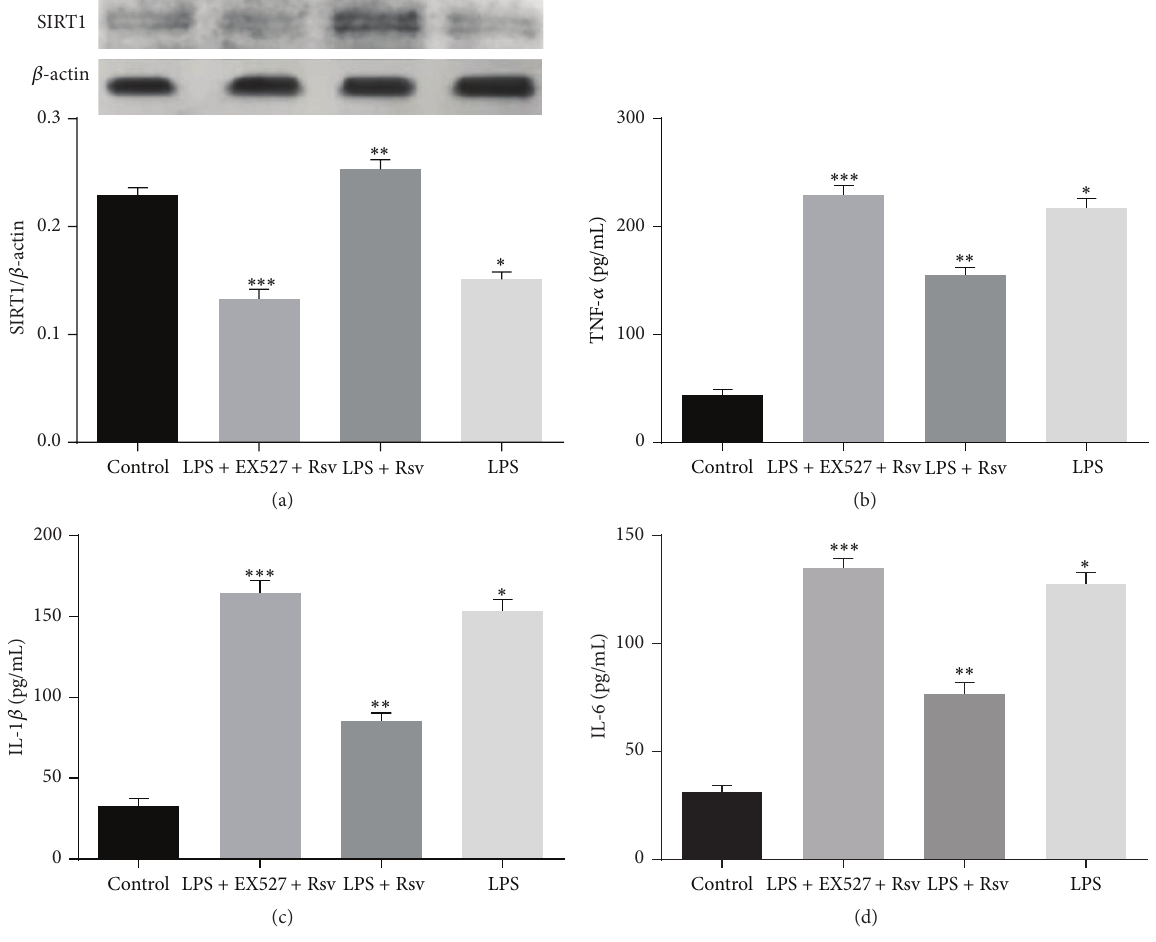
Figure 8: Neutralizing effects of EX527 on the protecting effects of Rsv on LPS stimulated NR8383 cells. (a) Expression of SIRT1 was evaluated by western blot and normalized to the expression level of 𝛽 -actin. LPS stimulation inhibited the expression of SIRT1 compared with that of control, ∗ 𝑃 < 0.05 versus control, while Rsv treatment significantly reversed the inhibiting effects, ∗∗ 𝑃 < 0.05 versus ∗ 𝑃 ; on the contrary, EX527 and Rsv cotreatment counterbalanced the enhancing effects of Rsv on the expression of SIRT1, ∗∗∗ 𝑃 < 0.05 versus ∗∗ 𝑃 . (b–d) Contents of TNF- 𝛼 , IL-6, and IL-1 𝛽 were evaluated by ELISA. LPS stimulation increased the generation of TNF- 𝛼 , IL-6, and IL-1 𝛽 in NR8383 cells compared with that of control, ∗ 𝑃 < 0.05 versus control, while Rsv treatment significantly inhibited the formation of those cytokines in NR8383 cells when stimulated by LPS, ∗∗ 𝑃 < 0.05 versus ∗ 𝑃 ; astonishingly, EX527 and Rsv cotreatment neutralized the inhibiting effects of Rsv on the generation of TNF- 𝛼 , IL-6, and IL-1 𝛽 . ∗∗∗ 𝑃 < 0.05 versus ∗∗ 𝑃